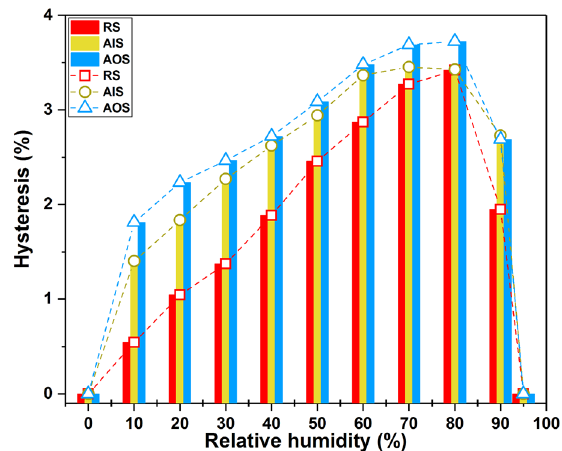
Figure 3. Sorption hysteresis of RS (red), AIS (yellow), and AOS (blue).